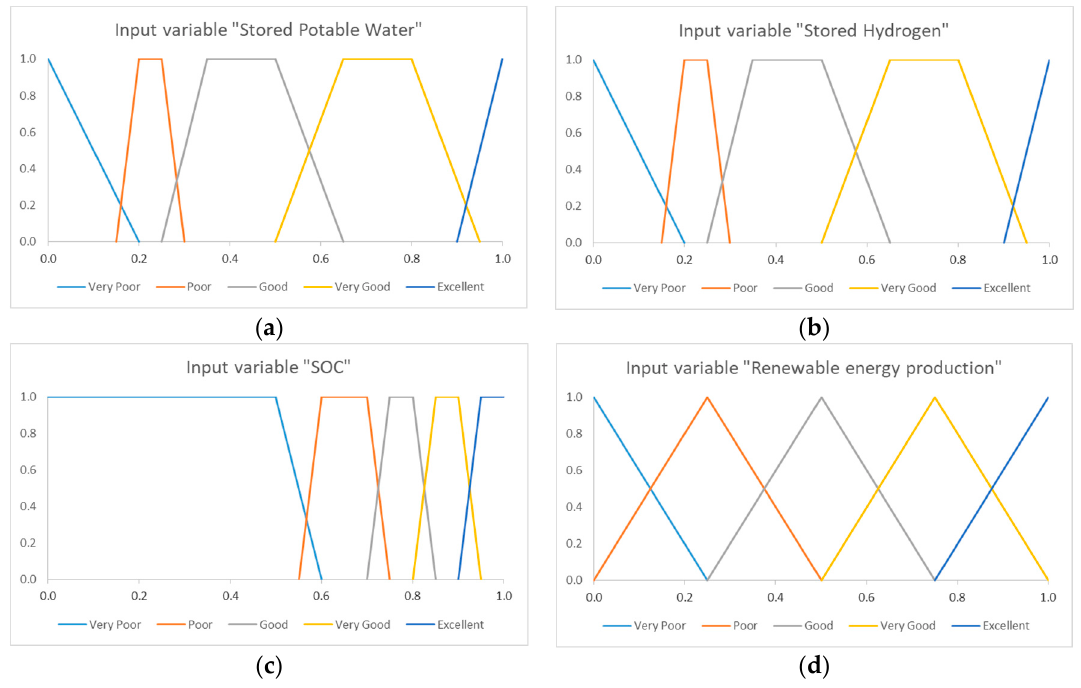
Figure 4. Membership curves for each input: ( a ) Stored Potable Water; ( b ) Stored Hydrogen; ( c ) SOC and ( d ) Renewable energy production.